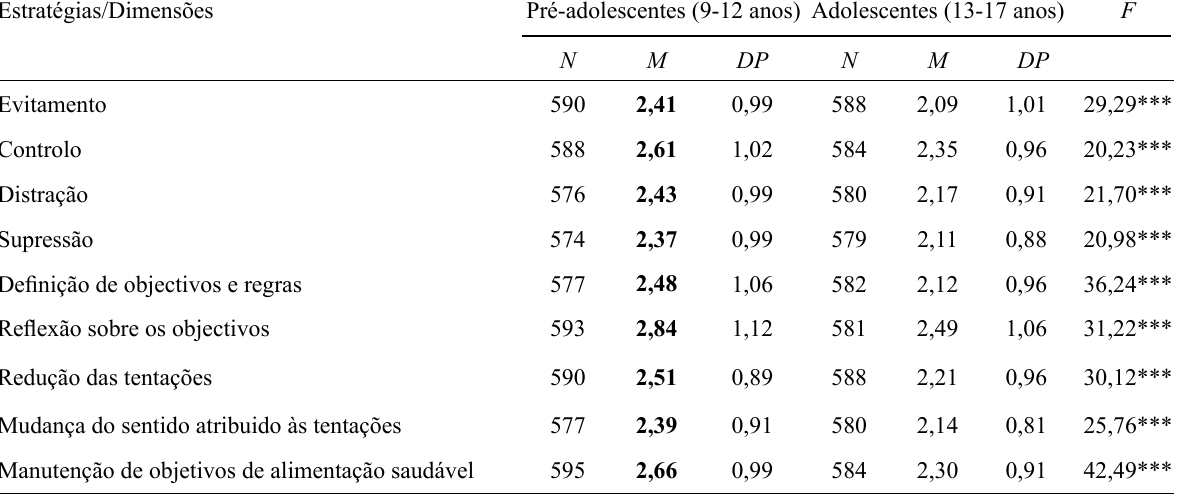
Nota . Em negrito os valores médios mais elevados (com signi fi cância estatística). *0,005-0,05; **0,001-0,005; ***0,000; ( ns ) = Não signi fi cativo (>